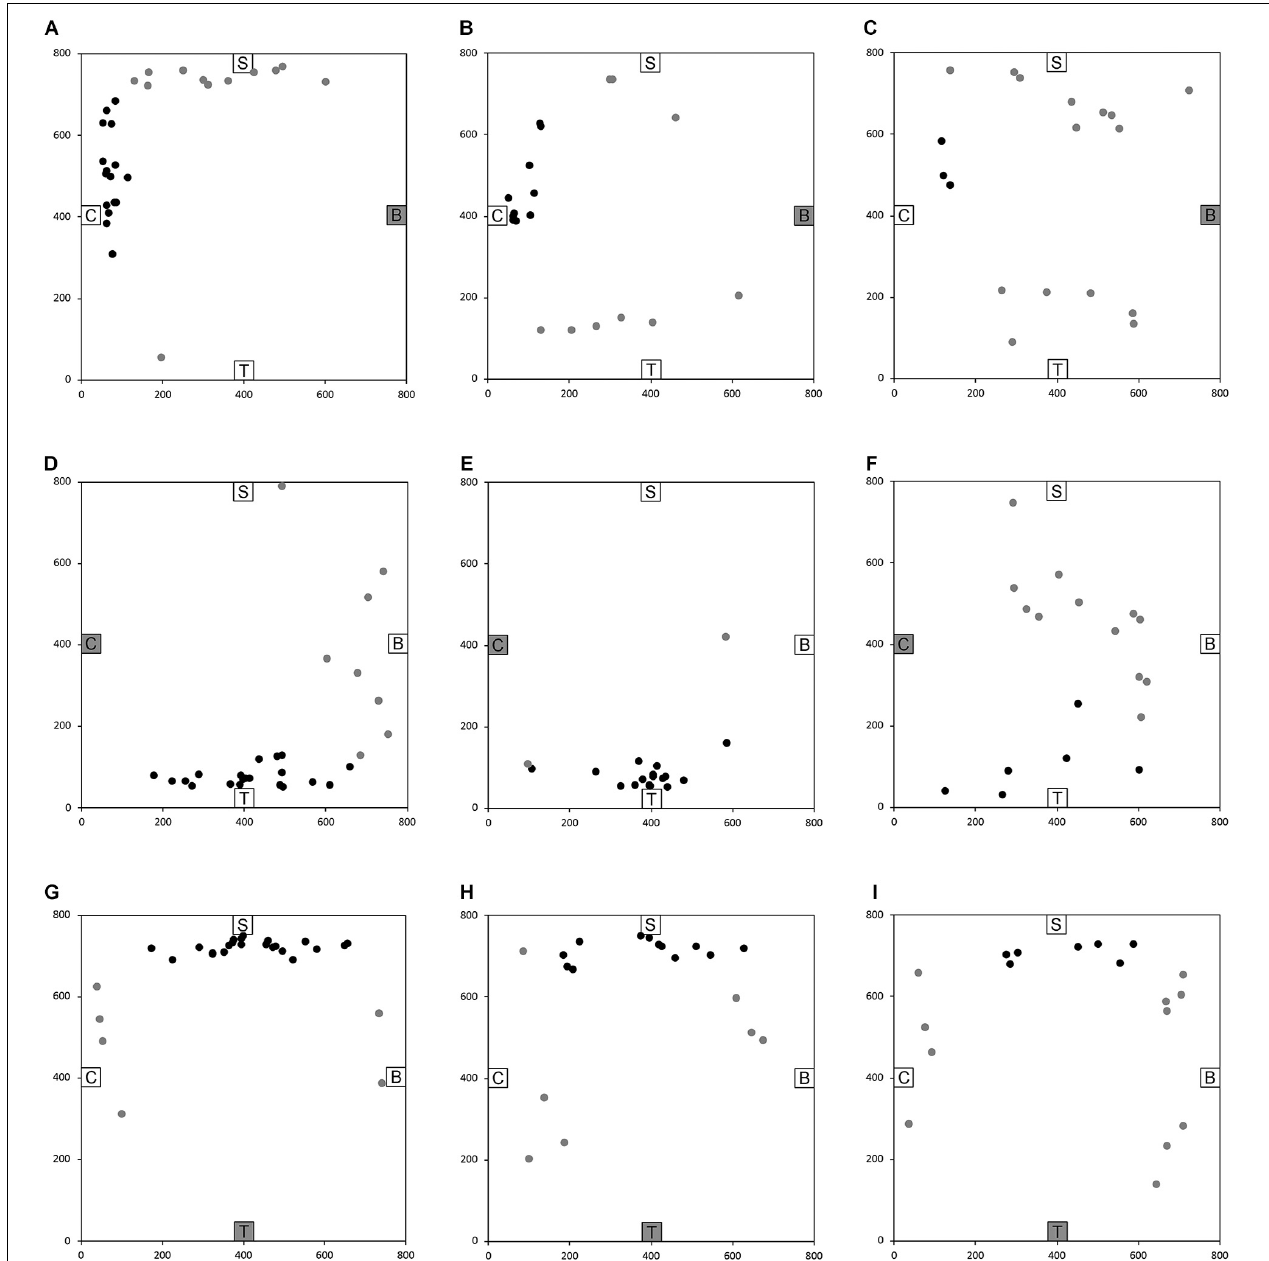
FIGURE 4 | End location of participants in the novel path trials of the allocentric cognitive mapping task. (A) Bench to Chair, TD: 16/28 individuals ended in the quadrant of the room where the target object was located (black dot: in the correct quadrant; gray dot: in an incorrect quadrant). (B) Bench to Chair, DS: 10/19 individuals in the correct quadrant. (C) Bench to Chair, WS: 3/18 individuals in the correct quadrant. (D) Chair to Table, TD: 20/28 individuals in the correct quadrant. (E) Chair to Table, DS: 17/19 individuals in the correct quadrant. (F) Chair to Table, WS: 6/18 individuals in the correct quadrant. (G) Table to Shelf, TD: 22/28 individuals in the correct quadrant. (H) Table to Shelf, DS: 12/19 individuals in the correct quadrant. (I) Table to Shelf, WS: 7/18 individuals in the correct quadrant. Room size: 800 cm × 800